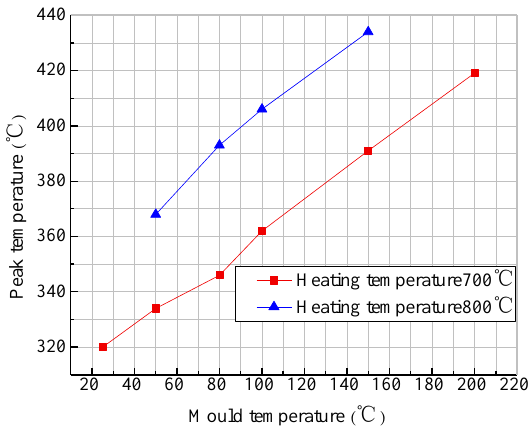
Figure 6. The change curve of peak temperature in the first layer under different mold temperatures.